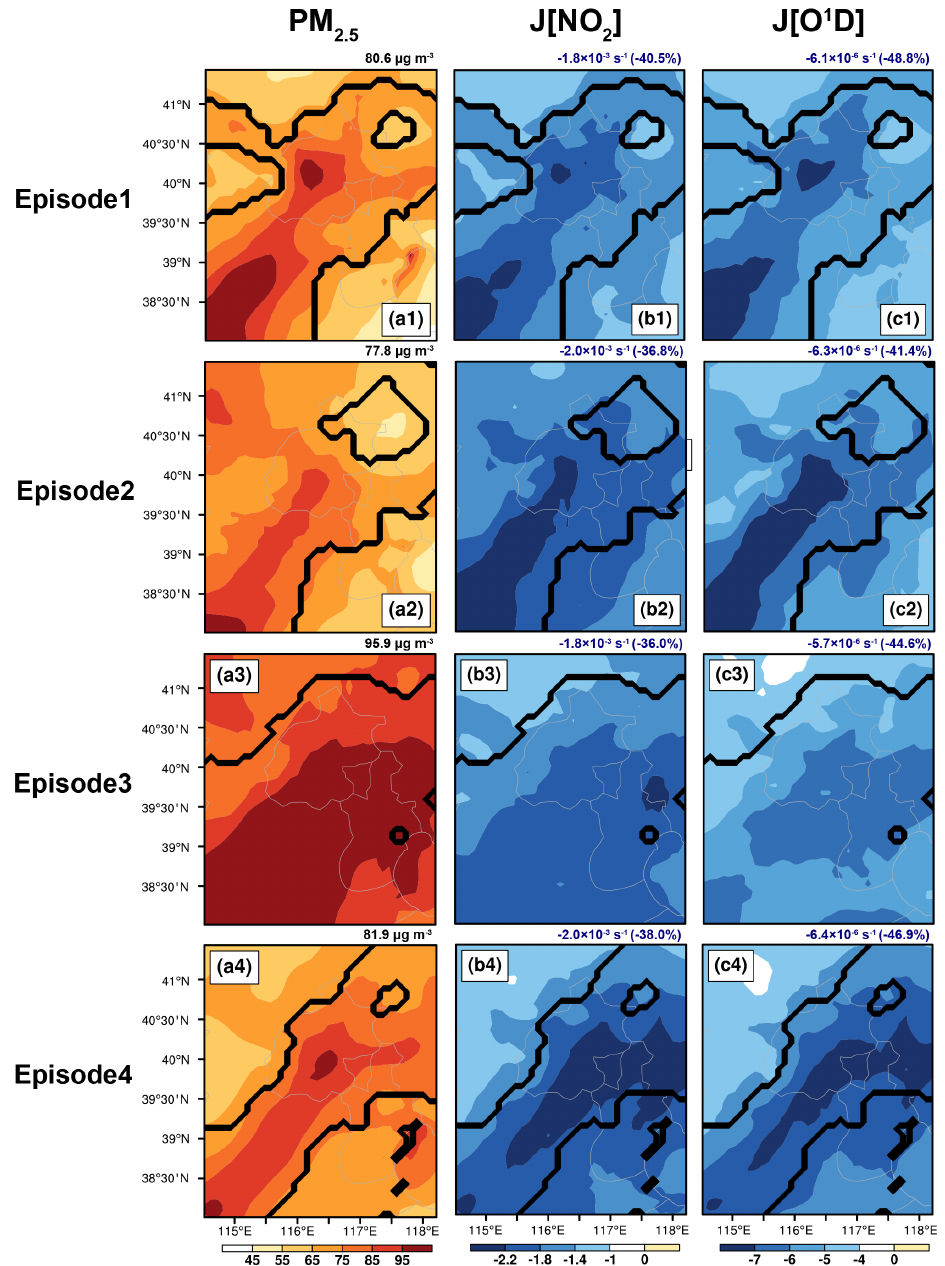
Figure 5. Spatial distributions of (a) simulated surface-layer PM 2 . 5 concentrations in BASE cases and the changes in surface (b) J [ NO 2 ] and (c) J [ O 1 D ] due to aerosol–radiation interactions in the daytime (08:00–17:00LST) during 28 July to 3 August 2014 (Episode1), 8–13 July 2015 (Episode2), 5–11 June 2016 (Episode3), and 28 June to 3 July 2017 (Episode4). The calculated values (percentage changes) averaged over CAPAs are also shown at the top of each